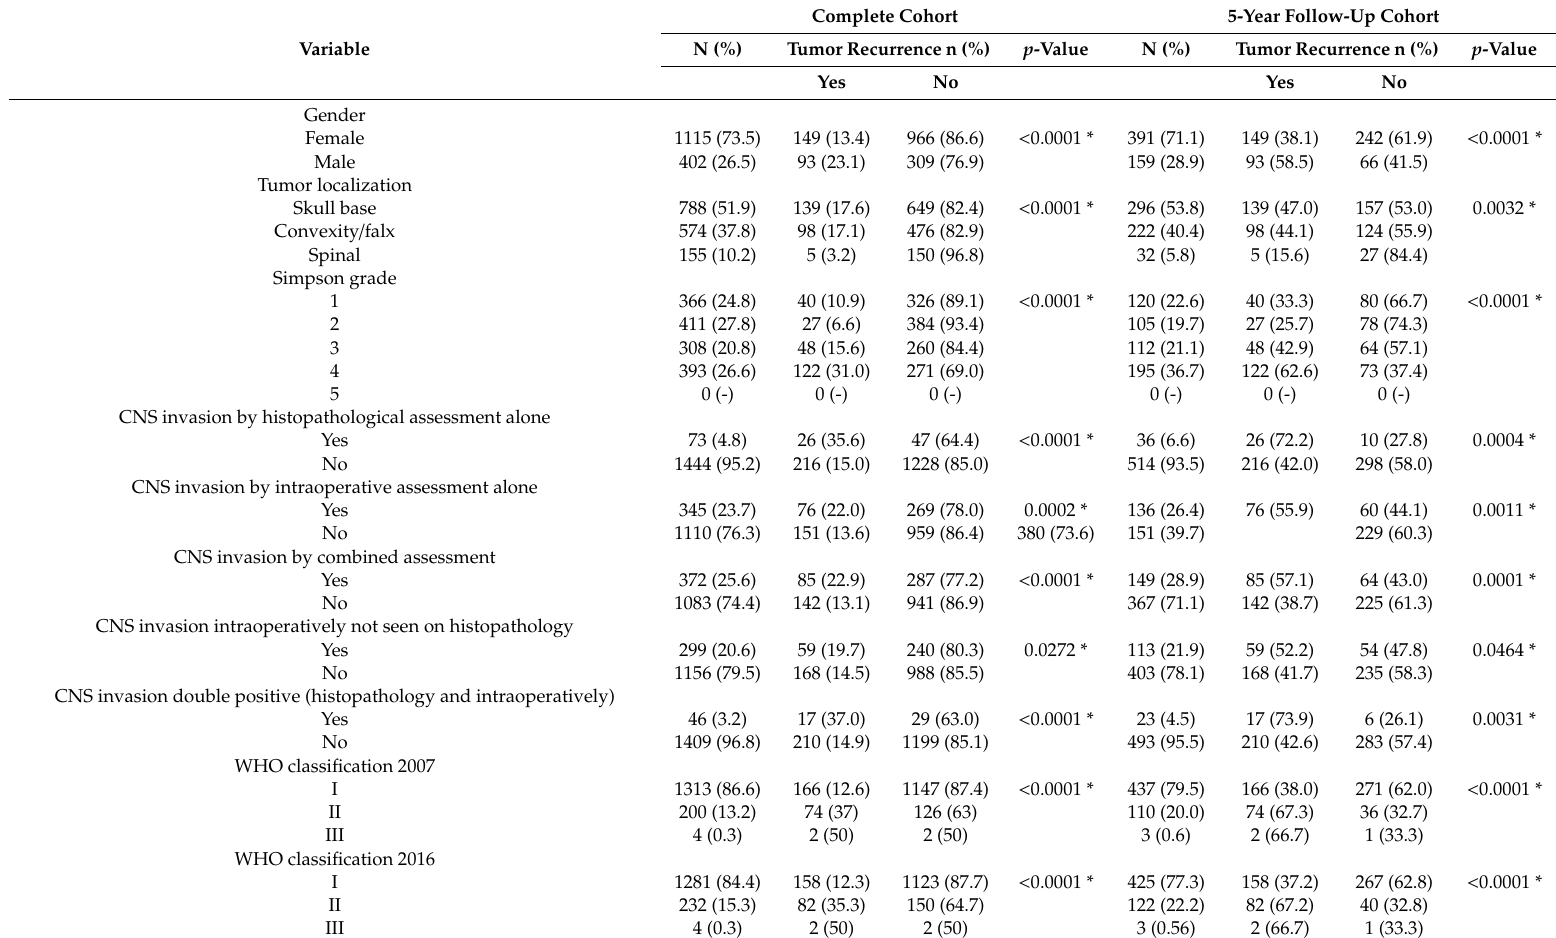
Table 1. Cohort characteristics and univariate analysis of tumor recurrence (chi-square